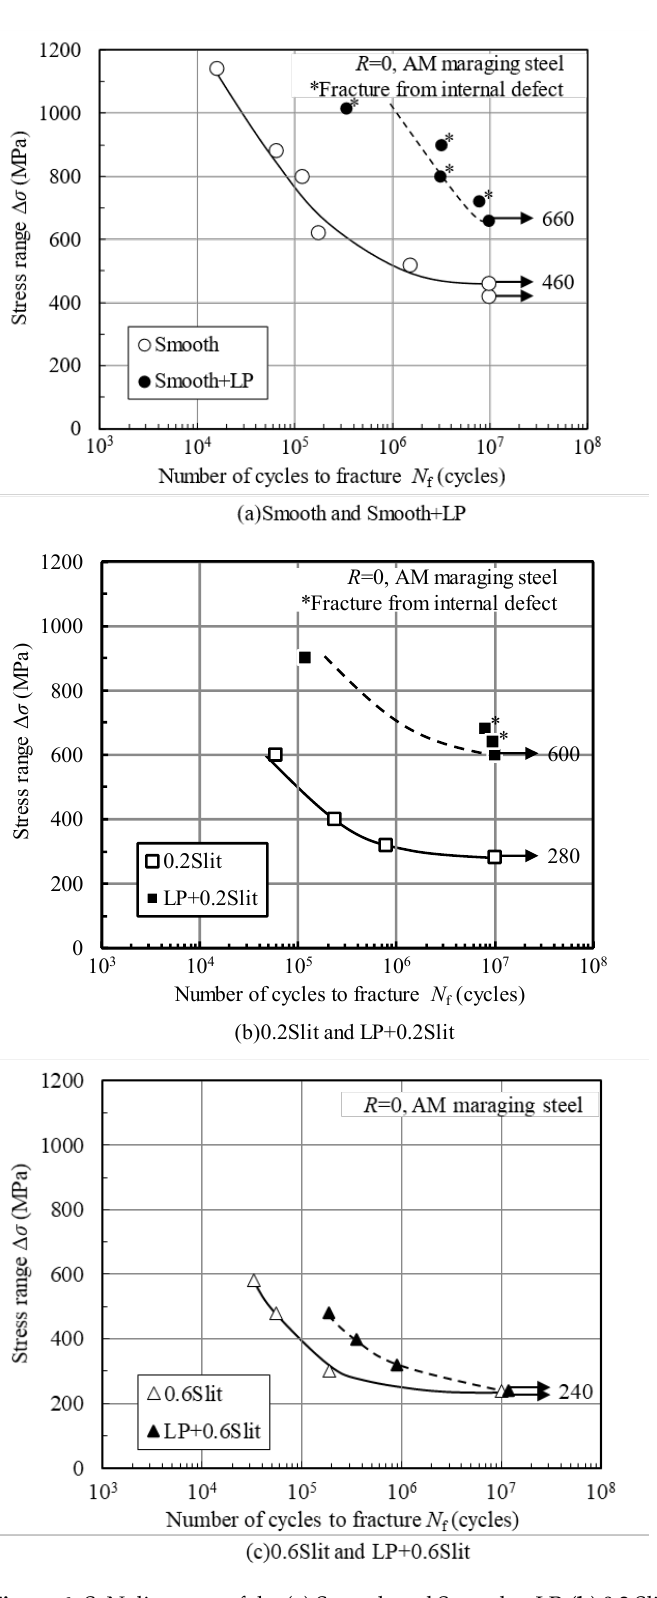
Figure 6. S–N diagrams of the ( a ) Smooth and Smooth + LP, ( b ) 0.2 Slit and LP + 0.2 Slit, and ( c ) 0.6 Slit and LP + 0.6 Slit specimens.